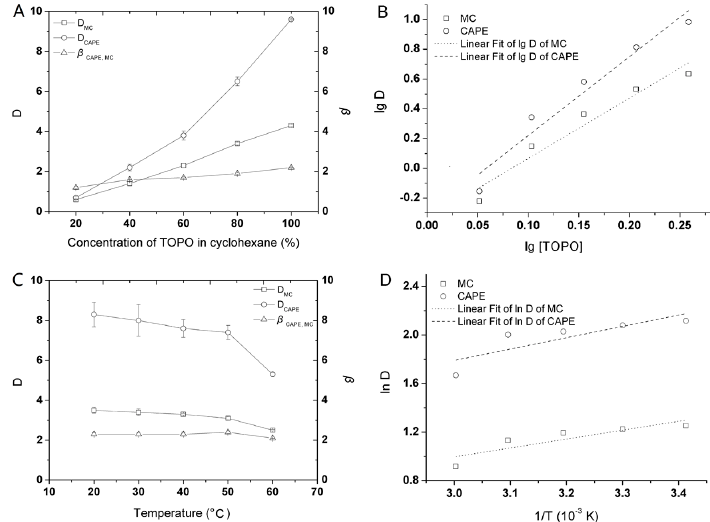
Figure 2. Effect of TOPO concentrations in equivoluminal cyclohexane on the complex formation of TOPO and caffeates from lipase-catalyzed transesterification reactants in [Bmim][Tf 2 N] ( A ) and lg D -lg [TOPO] curves of caffeates in the presence of TOPO ( B ); the effect of temperature on the complex formation of TOPO and caffeates from lipase-catalyzed transesterification reactants in [Bmim][Tf 2 N] using equivoluminal TOPO-cyclohexane ( C ) and lg D -1/ T curves of caffeates in the presence of TOPO ( D ). Each value is expressed as the mean ± standard deviation ( n = 3).